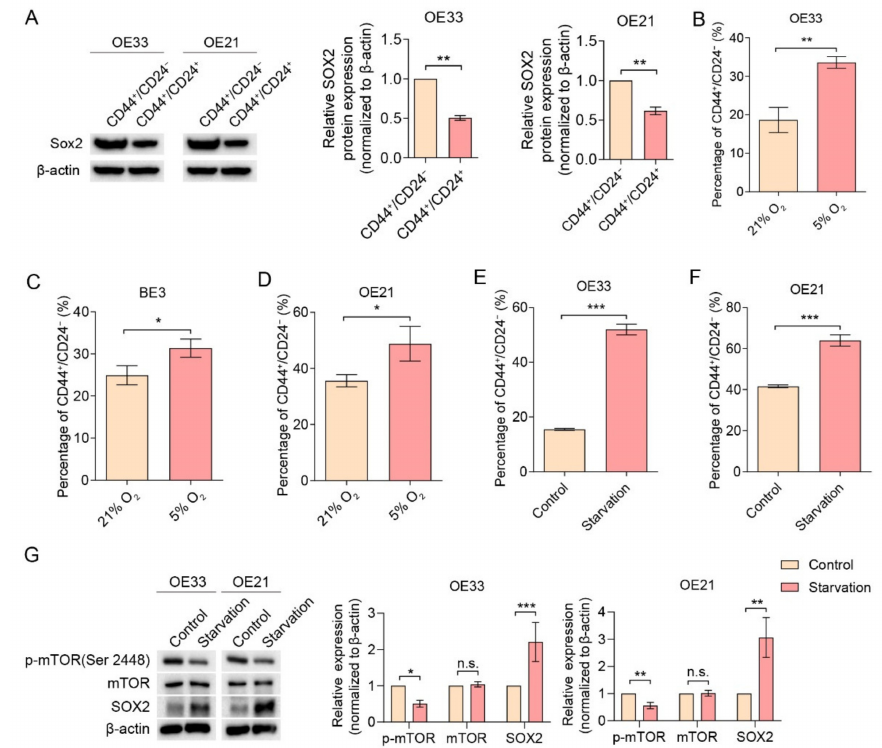
Figure 1. Reduced oxygen and nutrient deprivation selects for CD44 + /CD24 − CSC population and coincides with reduced mTOR phosphorylation. ( A ) CD44 + /CD24 − CSC population expresses